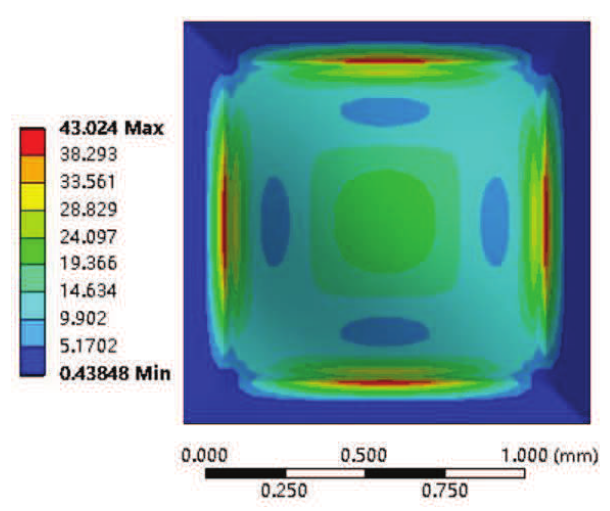
Figure 8. The Von-Mises stress nephogram of silicon cup with Finite Element